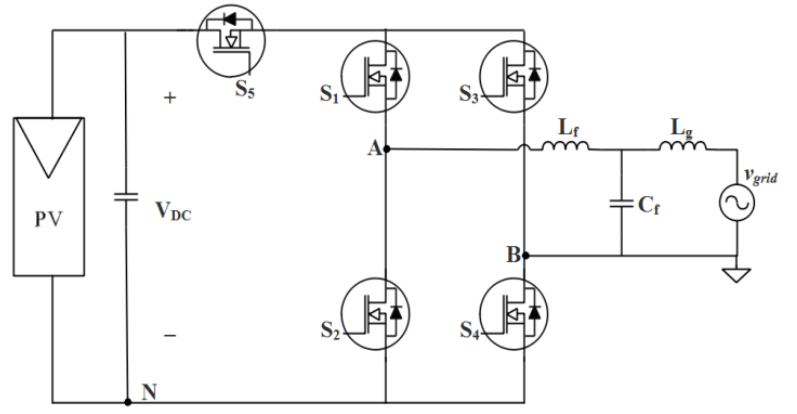
Figure 1. H5 topology.